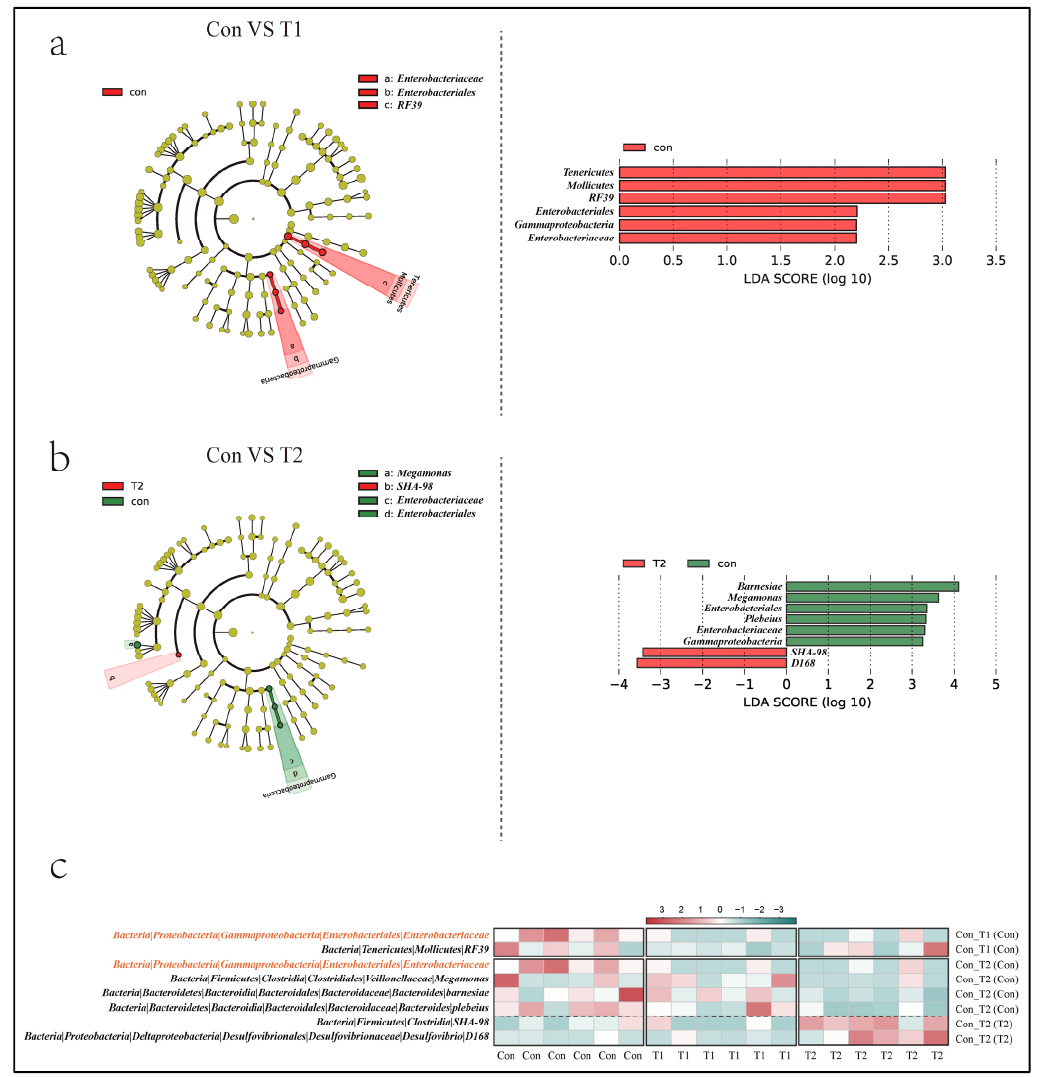
Figure 3. The significantly differentially abundant bacteria taxonomy identified by LEfSe analysis. ( a ) Cladogram plot ( left ) and Histogram of LDA value ( right ) between the Con and T1 group. ( b ) Cladogram plot ( left ) and Histogram of LDA value ( right ) between the Con and T2 group. ( c ) The heat map of the relative abundance of landmark microorganisms identified in the LEfSe in each group, the darker red represents the higher degree of enrichment, and the darker green represents the lower degree of enrichment . Taxa identified by LEfSe came from different levels. To further mine the potentially important bacteria at the genus level, we used a random forest classifier to define reliable biomarkers of the gut microbial response to SNK-6 (Figure 4a,b). In comparisons of the Con and T1 groups, the genera Ochrobactrum and [Eubacterium] were identified as a